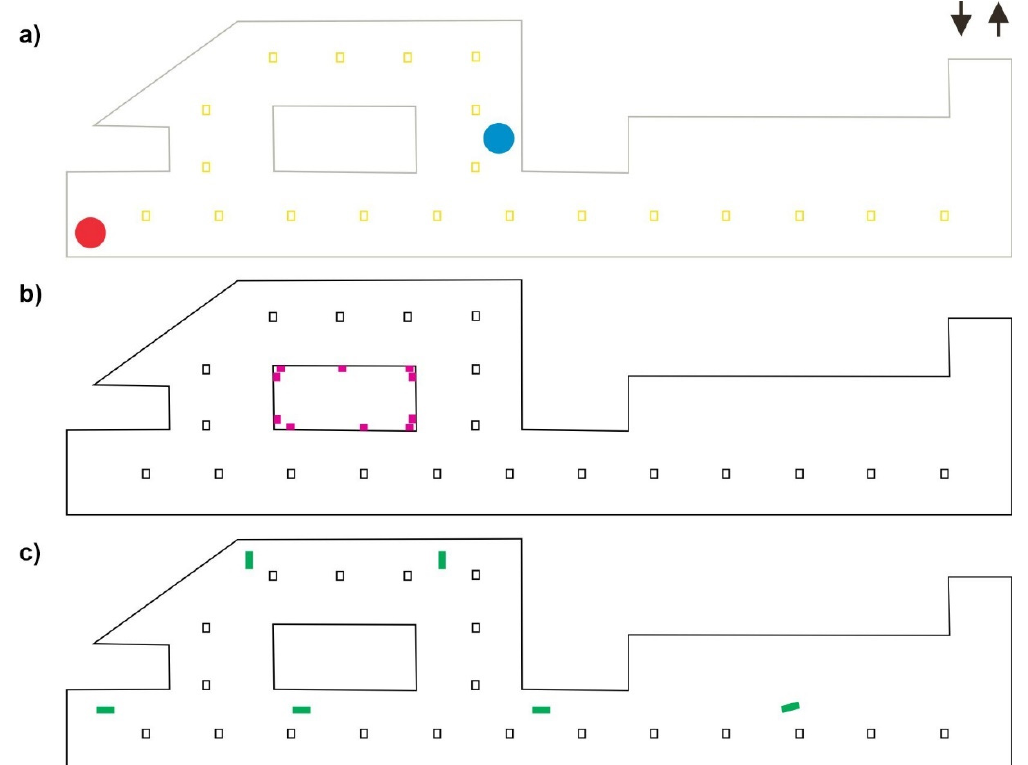
Figure 1. The scheme of analyzed object: ( a ) presents spatial configuration of pillars (yellow color), walls (grey color) and entry and exit to the garage (black arrows). The red circle represents first source of LPG dispersion, and the blue circle represents second source of LPG dispersion; ( b ) presents spatial configuration of ducts (violet color) and duct ventilation system; ( c ) presents spatial configuration of fans (green color) and jet ventilation system.